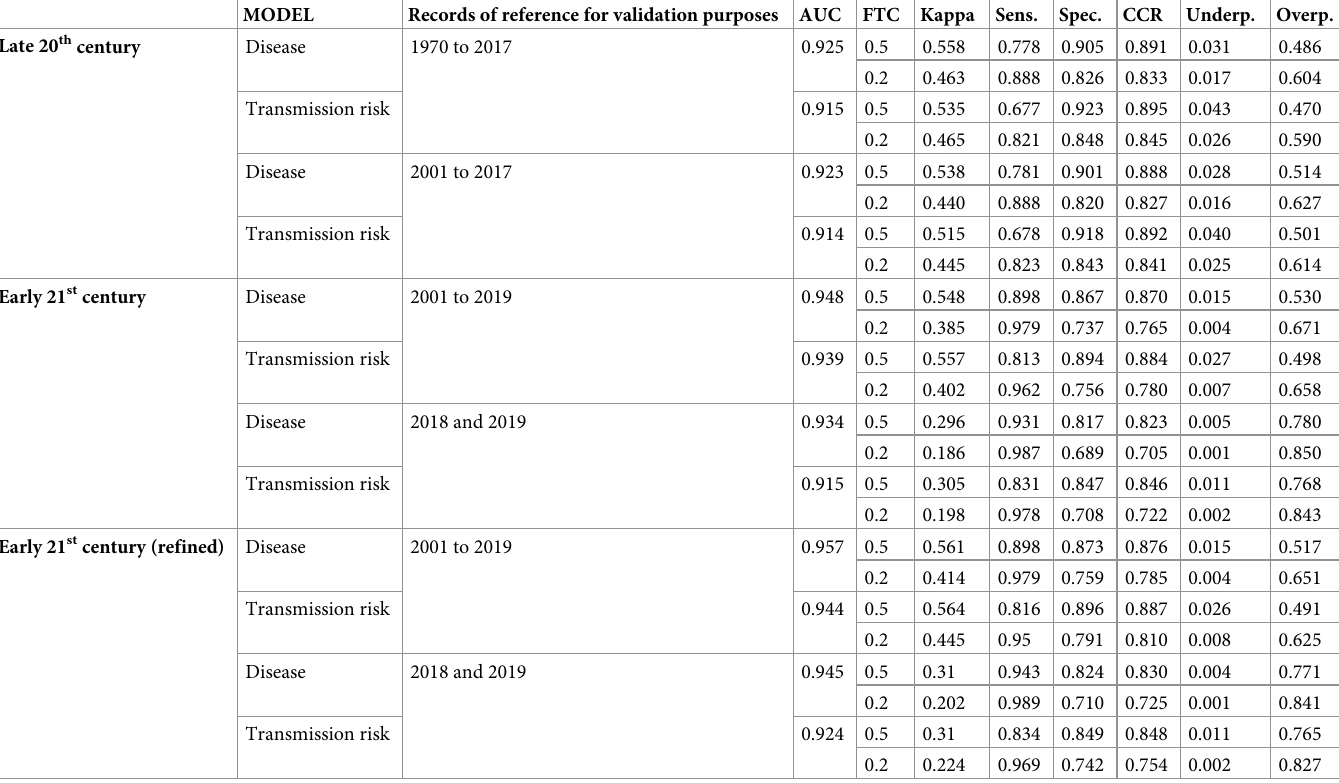
Table 2. Validation of model predictive capacity based on discrimination and classification performance respect to disease records of a later period. AUC: area under the receiver operator characteristic curve; FCT: favorability classification threshold; Kappa: Cohen’s kappa; Sens.: sensitivity; Spec.: specificity; CCR: correct classifi- cation rate; Underp.: underprediction rate; Overp.: overprediction